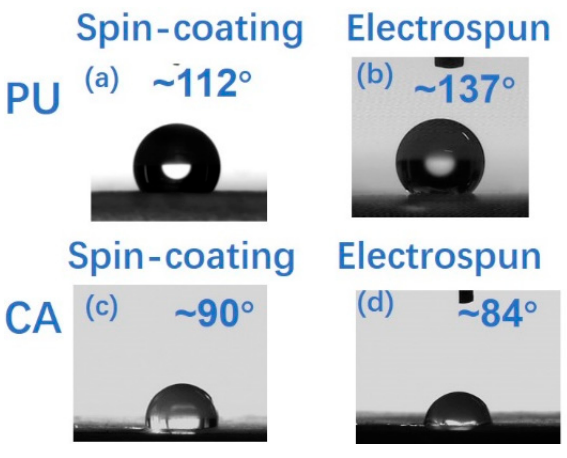
Figure 5. Water contact angles of PU and CA. ( a ) PU membrane prepared by spin-coating; ( b ) Figure5. WatercontactanglesofPUandCA.( a )PUmembranepreparedbyspin-coating; ( b )electrospun electrospun PU membrane; ( c ) CA membrane prepared by spin-coating; ( d ) electrospun CA PU membrane; ( c ) CA membrane prepared by spin-coating; ( d ) electrospun CA membrane.